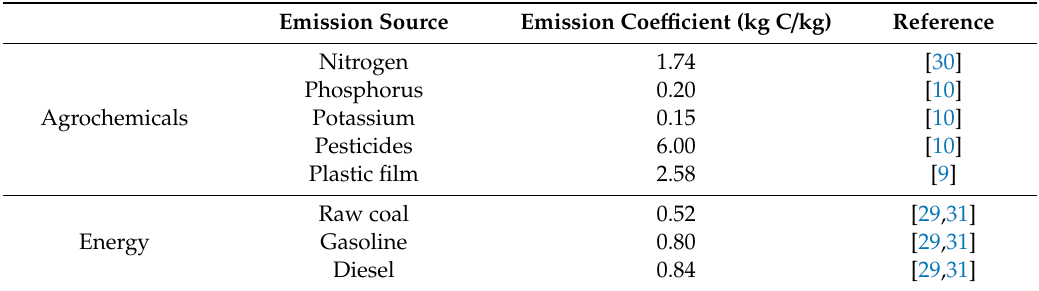
Table 1. Main emission sources and emission coe ffi cients in the agricultural sector in Qinghai